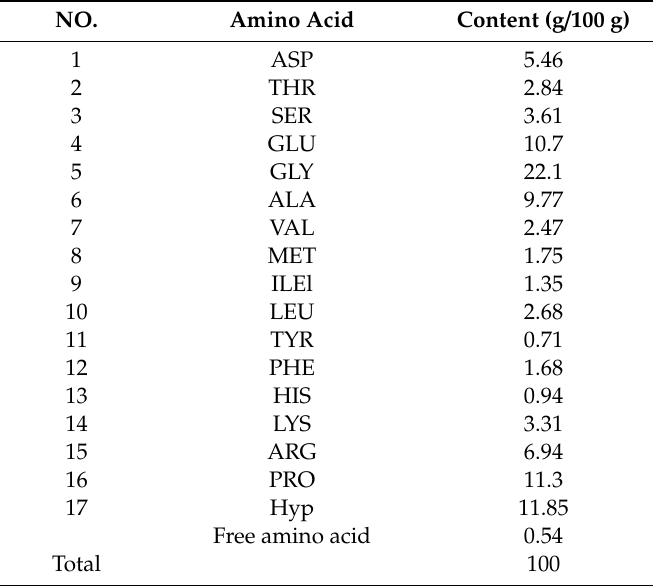
Table 1. Amino acid composition of collagen